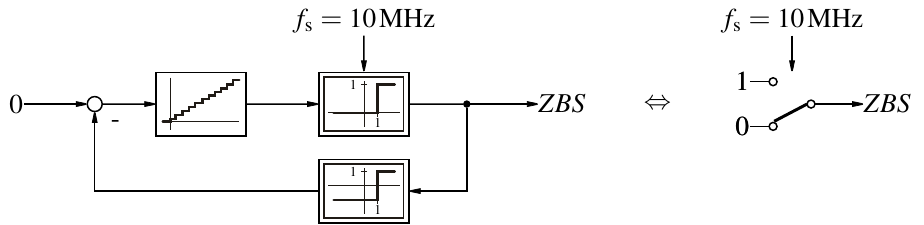
Figure 12. Zero bit-stream generator based on a first order ∆Σ -M and a simplified implementation.